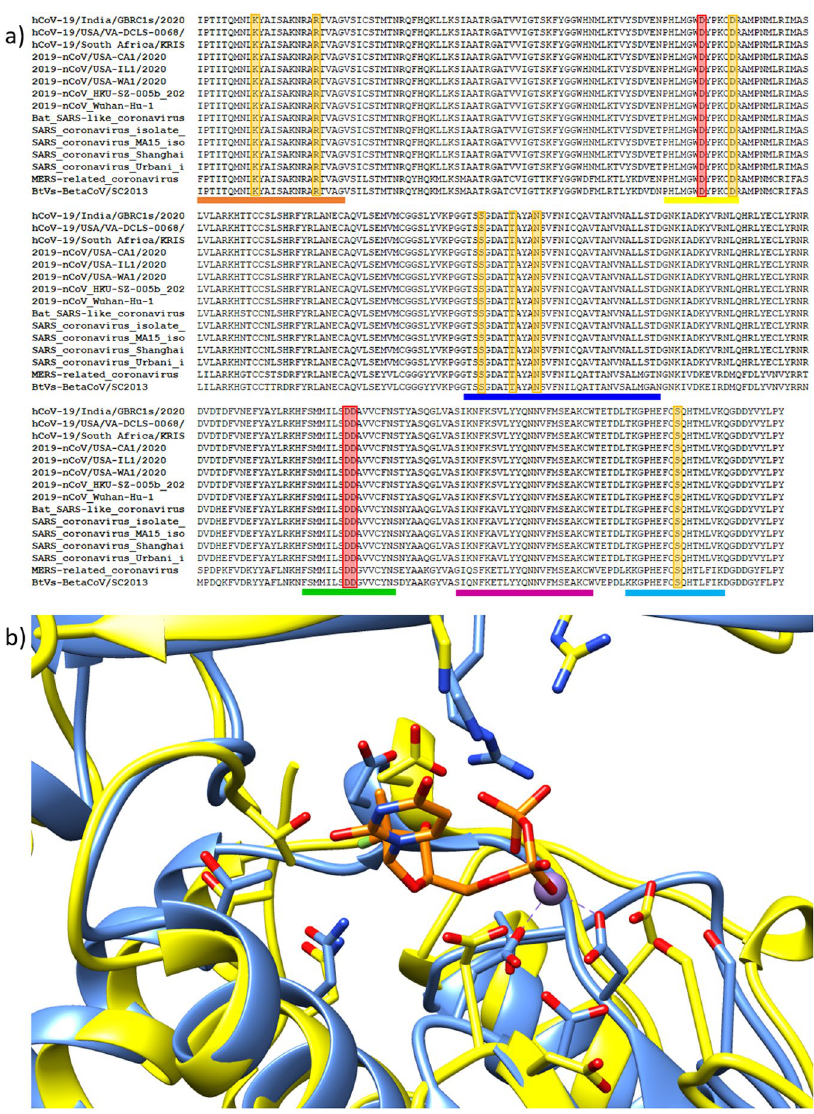
Figure 2. Conservation of the Sofosbuvir binding residues in members of the Betacoronavirus genus and structural superposition of SARS-Coronavirus nsp12 with hepatitis C virus NS5B bound to Sofosbuvir. ( a ) Multiple alignment of SARS-CoV-2 nsp12 and other coronaviruses including SARS-CoV and MERS-related coronavirus. The colored lines below the alignment mark the different structural motifs and are the same as Fig. 1; the residues that partake in Sofosbuvir binding are highlighted in orange, whereas the catalytic aspartates are highlighted in red. ( b ) The structural superposition of the two polymerases (HCV NS5B is colored blue; SARS-CoV nsp12 is colored yellow) shows the high degree of conservation in the active site. The sidechains of the residues partaking in Sofosbuvir binding are shown, and sofosbuvir is colored